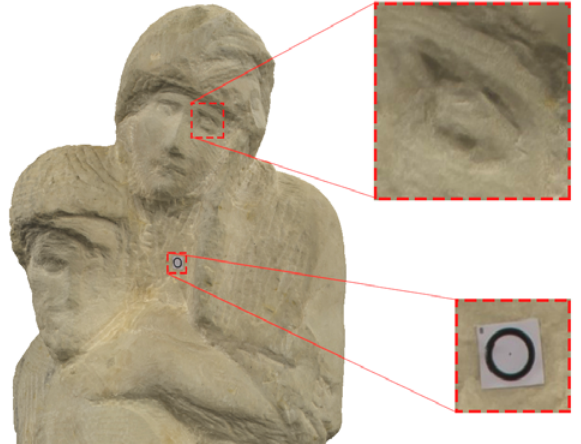
Figure 13. Details of the 1:1 high-resolution texture directly onto the